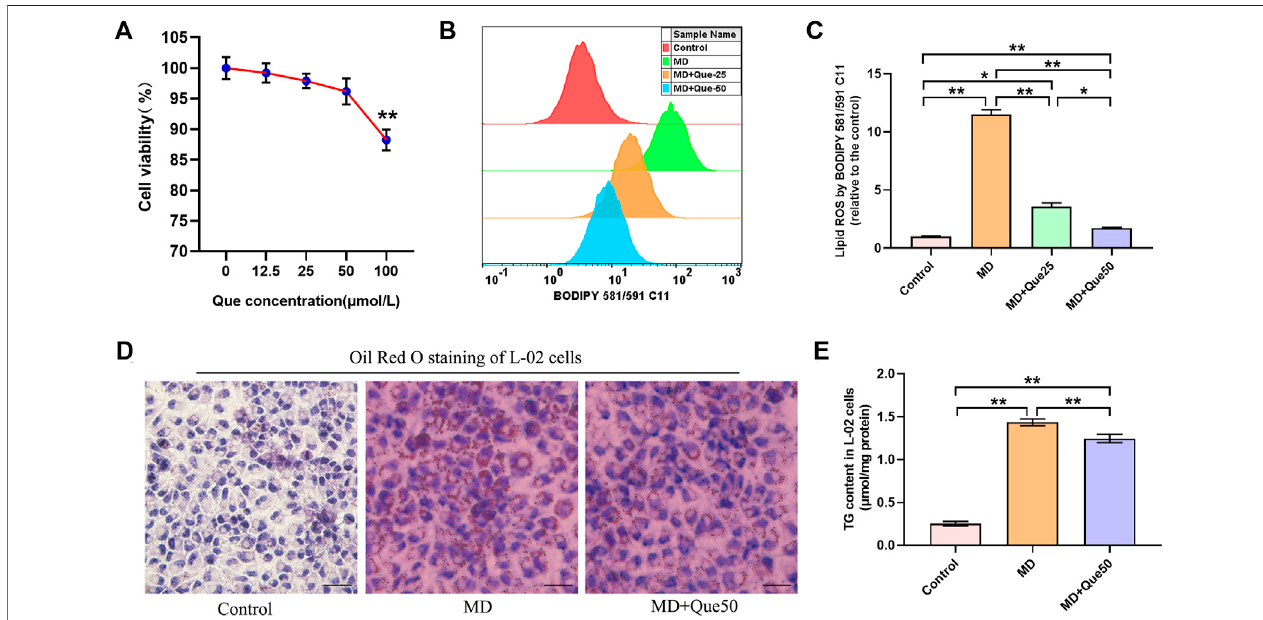
FIGURE 4 | Que reduced lipid ROS and lipid droplet accumulation in steatotic L-02 cells ( n = 3). (A) The effect of Que treatment on L-02 cell viability. (B) Representative fl uorescence intensity images of cellular lipid ROS by BODIPY 581/591 C11 obtained by fl ow cytometry. (C) Flow cytometric analysis of fl uorescence intensity. (D) Oil Red O staining of L-02 cells (scale bar = 50 μ m). (E) TG content in L-02 cells. The data are expressed as the mean ± SD from three independent experiments. **, p < 0.01 and *, p <